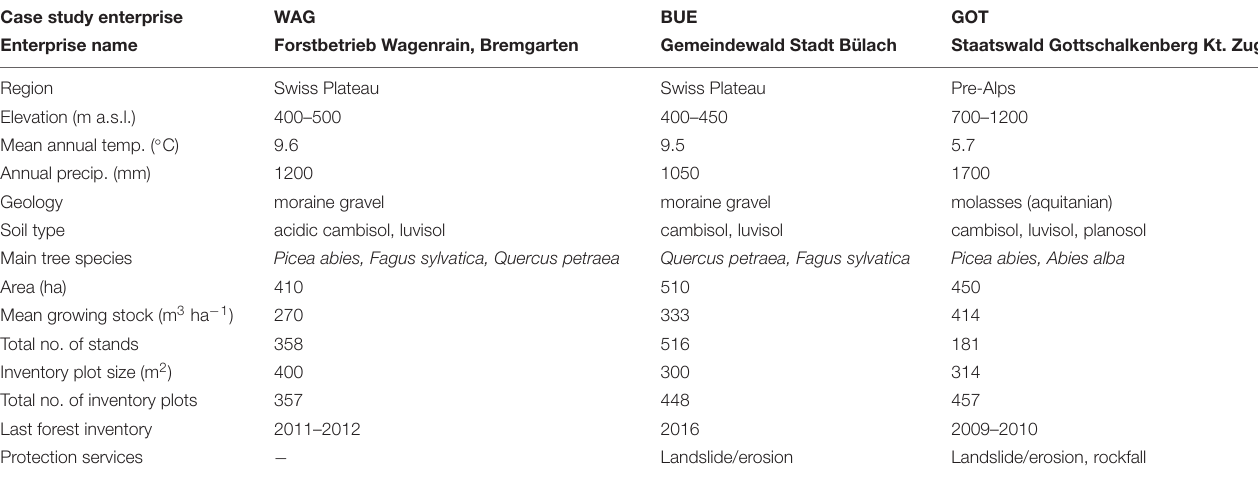
TABLE 1 | Environmental conditions, forest composition, and inventory plot information for each case study